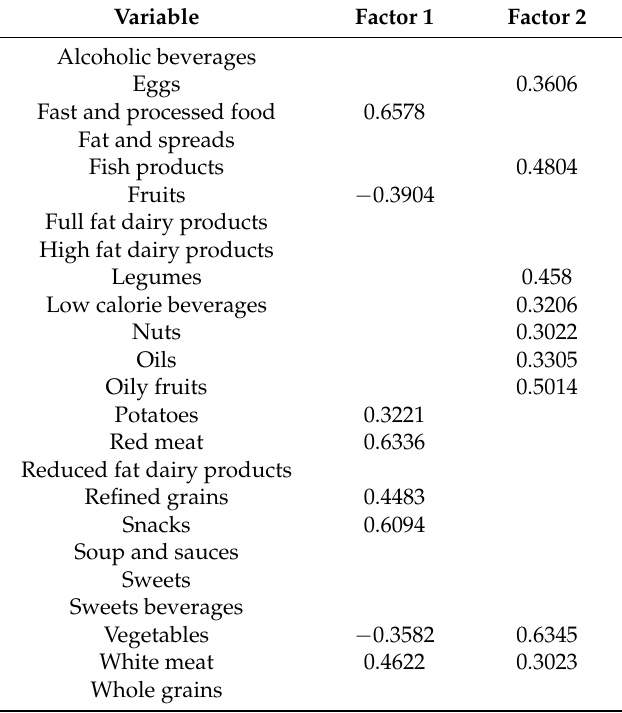
Table 2. Factor loading of pattern